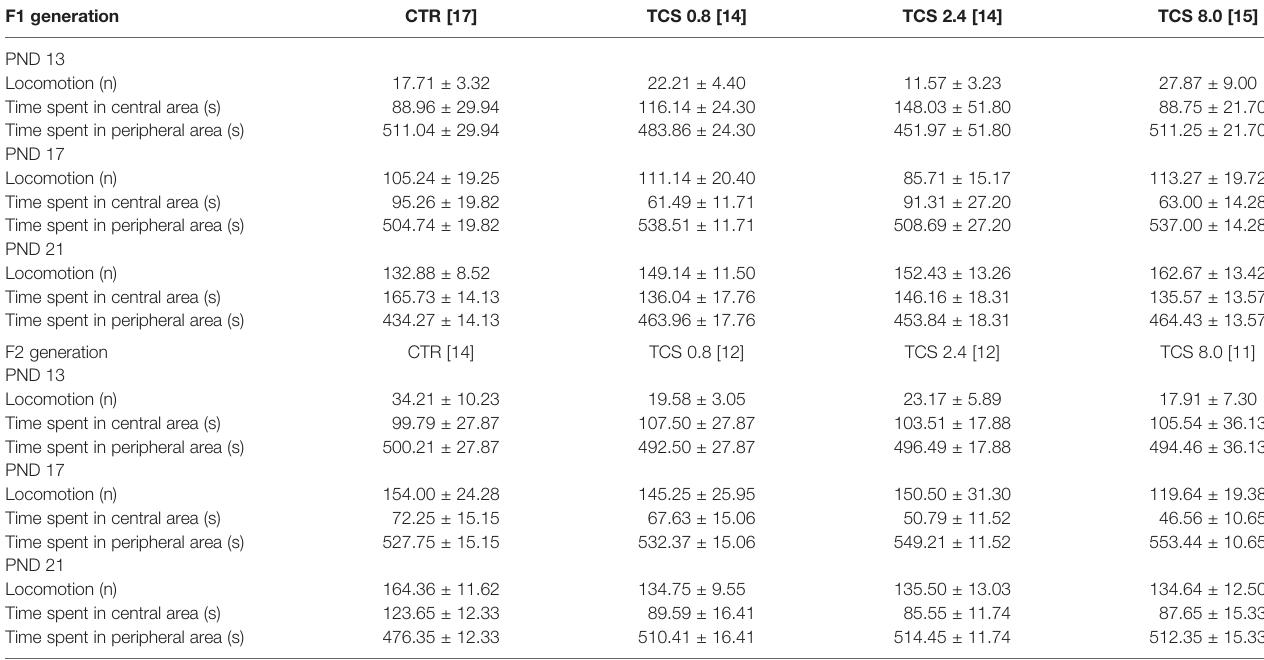
TABLE 7 | Locomotor behavior of male rats from F1 and F2 generations in the open- fi eld test. F1